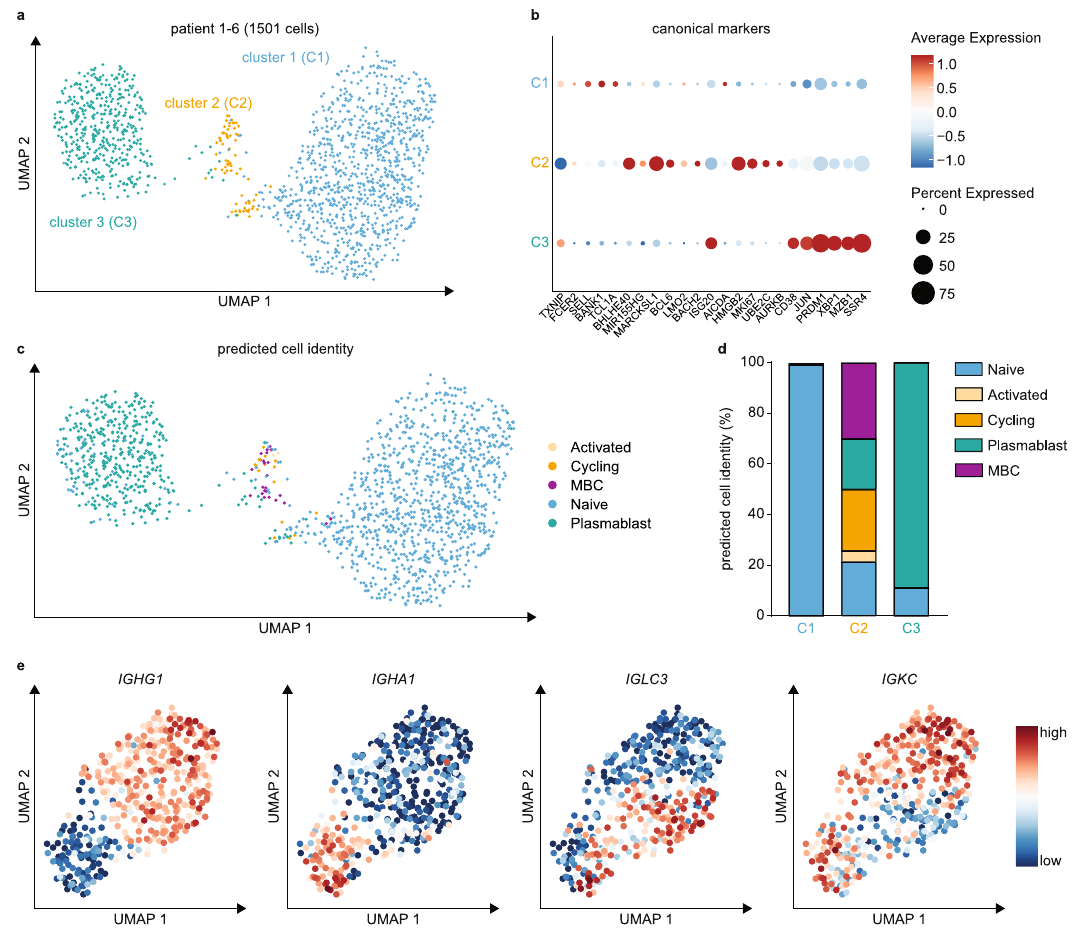
Fig. 1 Single cell RNA sequencing of tumor-in fi ltrating B-cells. a UMAP projection of endometrial cancer B-cell scRNA-seq data (1501 cells; 6 donors) annotated by cluster. b Dotplot of canonical B cell subtype marker genes per cluster. c Predicted cell identity for Cluster 1, Cluster 2 and Cluster 3 cells assigned using reference scRNA-seq data of a human lymph node. Cell identities are projected onto the endometrial cancer B-cell UMAP from a . d Quanti fi cation of predicted cell identities per cluster. e UMAP projection of Cluster 3 plasmablasts with Feature Plots depicting IGHG1, IGHA1, IGLC3 and IGKC expression in single cells. UMAP Uniform Manifold Approximation and Projection; MBC Memory B cell. Source data are provided as a Source Data fi